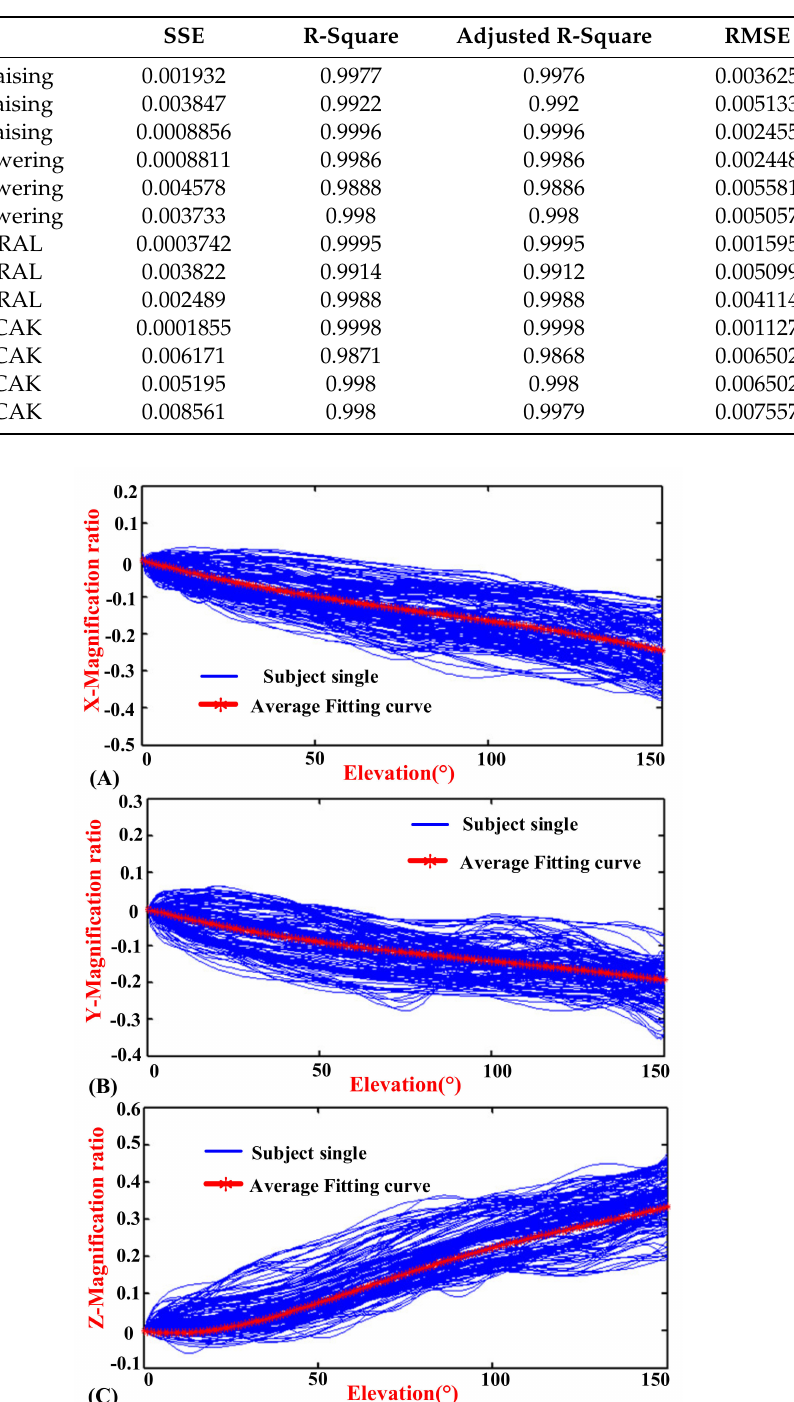
Table 1. Indexes of fitting curve for modified and CAK-model.